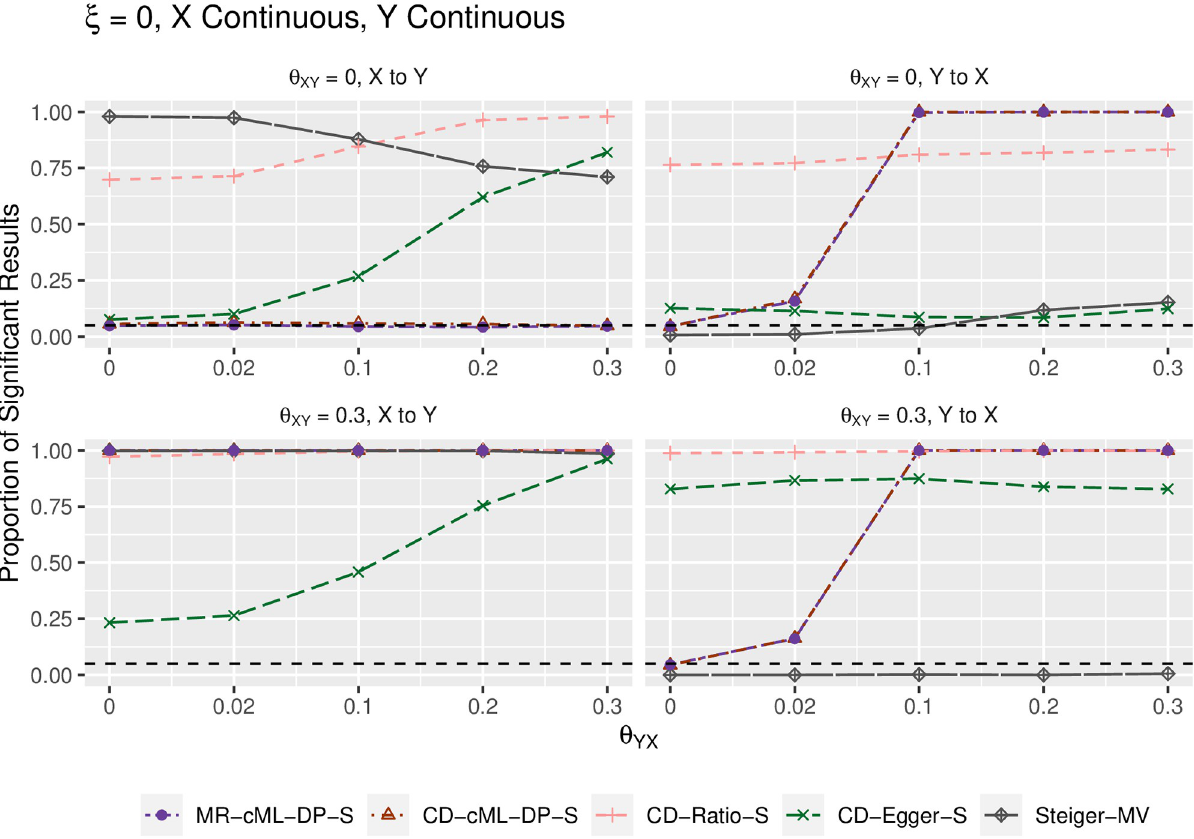
Fig 2. Empirical type-I error and power (y-axis) for both X and Y continuous, ξ = 0 (i.e. no correlated pleiotropy), θ XY = 0 (top panels) and θ XY = 0.3 (bottom) for various values of θ (x-axis). The left panels show results for the direction X ! Y , the right ones show results for the direction Y ! YX X